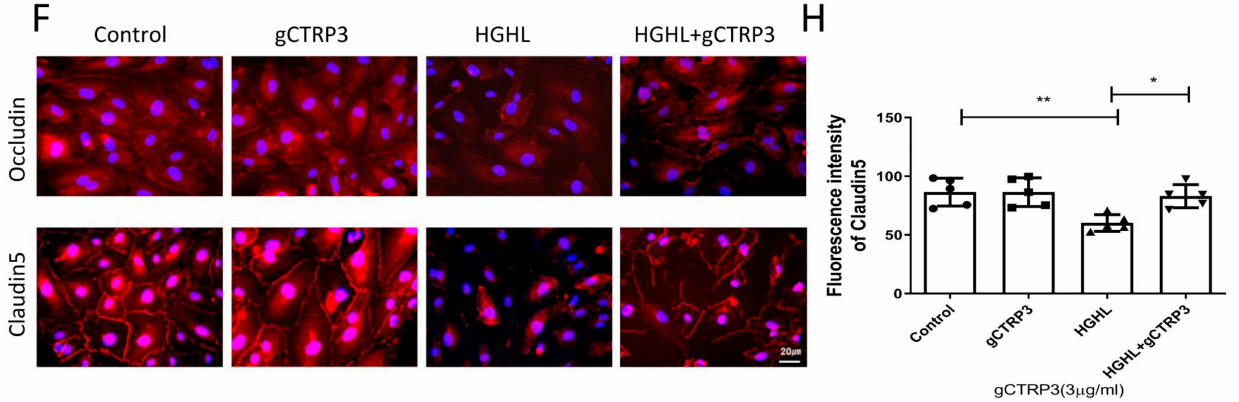
Figure 3. gCTRP3 protected barrier function of iBRB against HGHL-induced damage. ( A ), Rep- resentative images of tube formation assay showing that gCTRP3 failed to promote HREMC tube formation. ( B ), Bar graph for tube formation analysis, n = 5. ( C ), Representative images for xCEL- Ligence electrical conductivity assays showing that gCTRP3 increased cellular connection. ( D ), Bar graph analysis for xCELLigence conductivity assay. ( E ), Bar graph analysis for trans-well endothelial permeability assay. ( F ), Immunoflurencence images showing that HGHL disrupted cell-to-cell junc- tions in HRMECs staining with Occludin (red), Claudin-5 (red), Nuclei (blue). ( G , H ), Fluorescence intensity quantification of Occludin (red), Claudin-5. HRMECs were treated with vehicle or HGHL for 24 h followed by CTRP3 administration (3 µ g/mL). All data are shown as means ± SD. n = 5 for each group. Bar graph represents analysis from at least 5 independent repeated